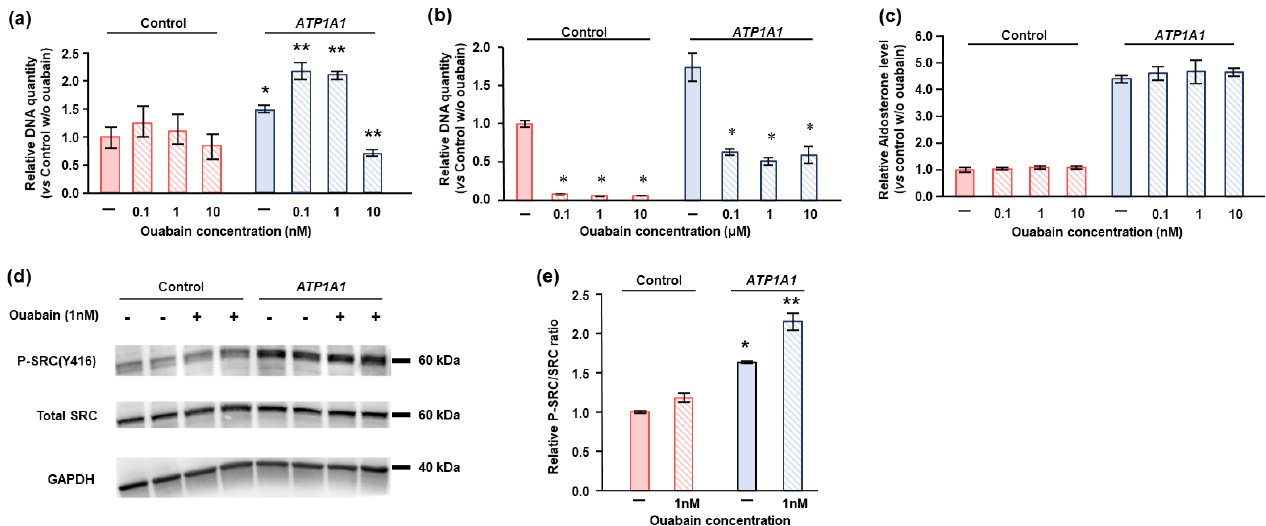
Figure 5. Ouabain enhanced cell proliferation of HAC15 cells with the ATP1A1 L104R mutant, but did not increase aldosterone production. ( a ) After transduction of the ATP1A1 mutant ( n = 6) or control ( n = 6) vectors in HAC15 cells and incubation with or without ouabain at the indicated concentration on 96-well plates for 3 days, the amount of DNA was measured by CyQUANT Direct Cell Proliferation Assay Kit. *, p < 0.05 vs. each type of control cells. ( b ) After transduction of ATP1A1 mutant ( n = 3) or control ( n = 3) vectors in HAC15 cells and incubation with or without ouabain at the indicated concentration for 3 days, cells were serum deprived in DMEM/F12 containing 0.1% serum on 24-well plates for 24 h. Cells were incubated with fresh media with 0.1% serum for 24 h, and then aldosterone levels of the supernatant were measured. Aldosterone levels were normalized based on cellular protein levels. *, p < 0.05 vs. each control cells. ( c ) After transduction of ATP1A1 mutation ( n = 6) or control ( n = 6) and incubation with or without ouabain at indicated concentration on 96- well plates for 3 days, the amounts of DNA were measured by CyQUANT Direct Cell Proliferation Assay Kit. *, p < 0.05 vs. each control cells. ( d , e ) After transduction of ATP1A1 mutant ( n = 3) or control ( n = 3) vectors in HAC15 cells and incubation with DMEM/F12 containing 0.1% serum on 12-well plates for 24 h, cells were incubated with fresh media in- cluding 10% serum with or without 1 nM of ouabain for 5 m. *, p < 0.05 vs. control cells without ouabain. **, p < 0.05 vs. the other three type of cells.